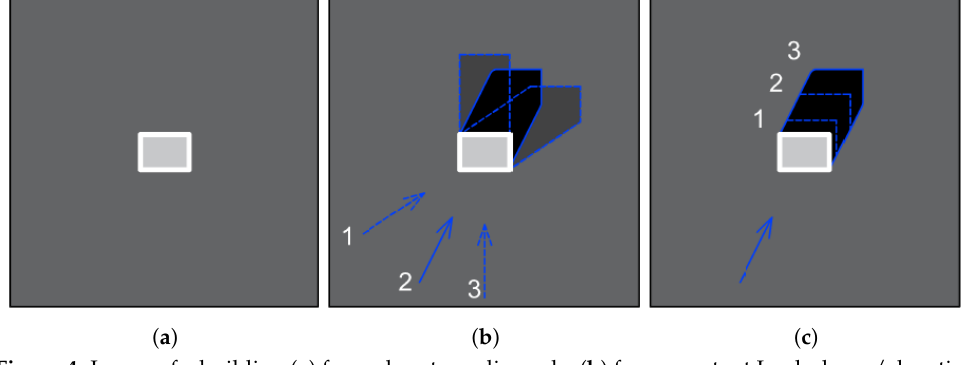
Figure 4. Image of a building ( a ) from close to nadir angle, ( b ) from constant Look-down/elevation angle and three azimuth angles, ( c ) from constant azimuth with different look-down angles (1 is the highest, 3 is the